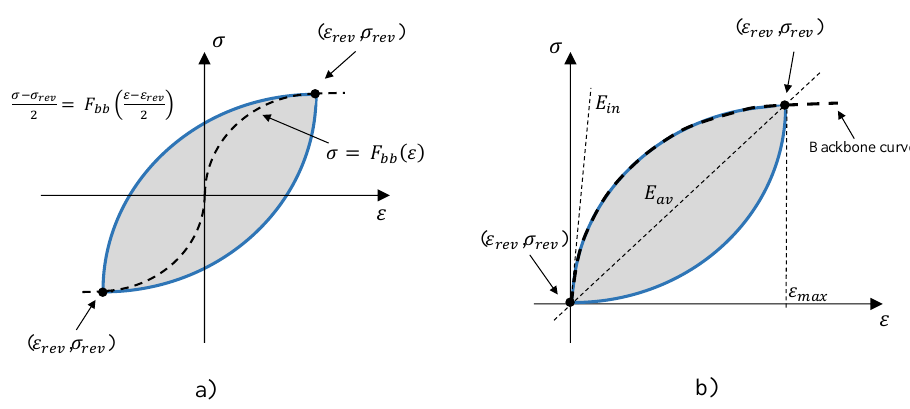
Figure 4. ( a ) Masing’s rule for an irreversible stress–strain behaviour. ( b ) Schematic of the reference hysteresis cycle of reference for the proposed hysteresis